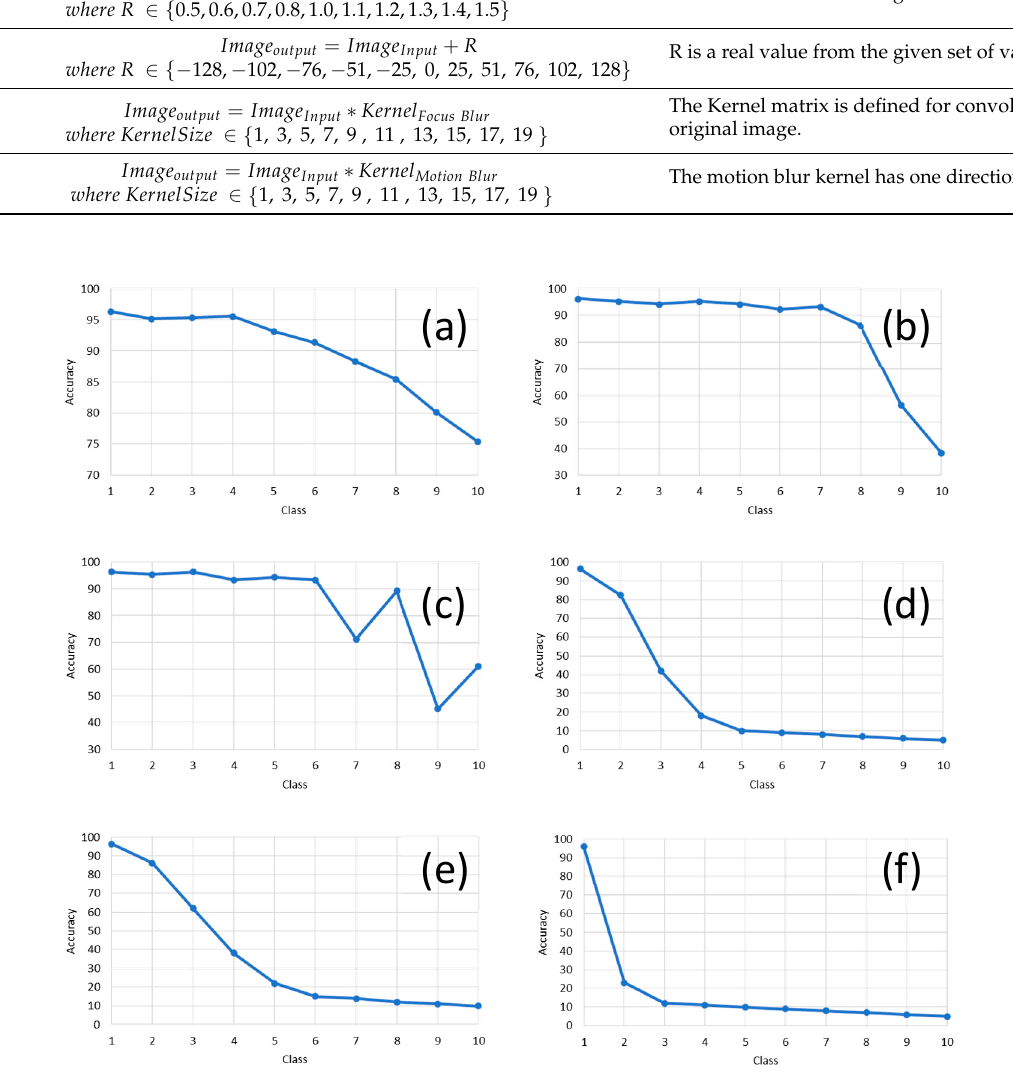
Figure 15. The effect of different artifacts on our best classifier’s accuracy (Model V). The class value shows the amount of injected distorting artifacts in the original clean image based on the parameter sets presented in Table 4. Scenarios: ( a ) Effect of Gaussian noise injection; ( b ) Effect of contrast change injection; ( c ) effect of brightness change injection; ( d ) effect of focus blur injection; ( e ) effect of motion blur injection; and ( f ) Effect of combined artifacts injection.